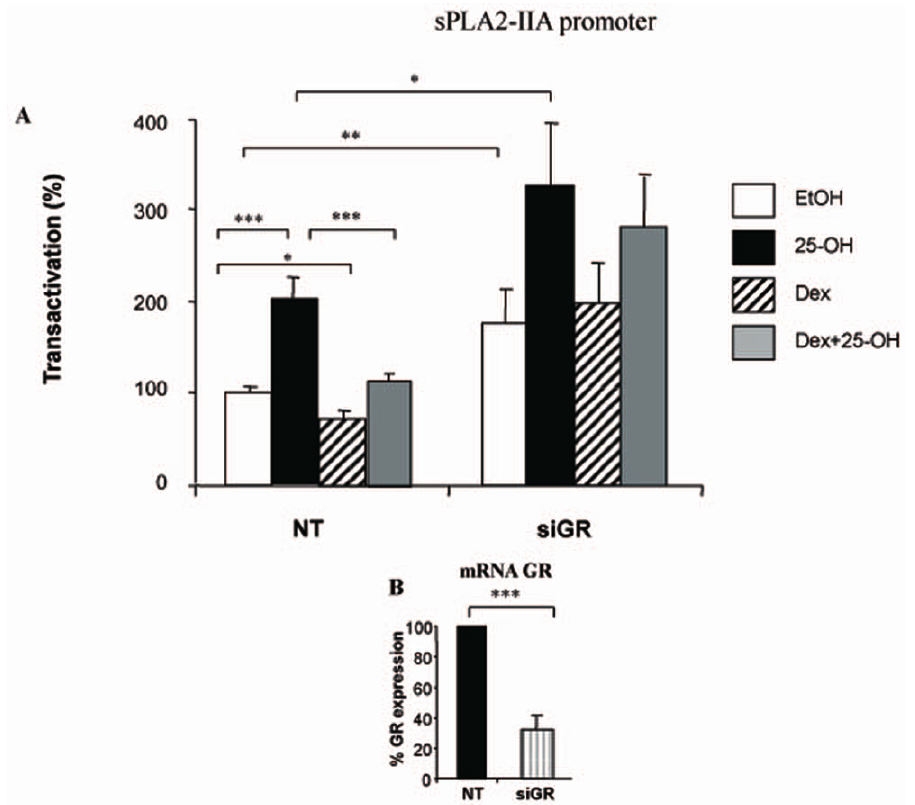
Figure 1. Effect of Dex and implication of the GR in sPLA2-IIA promoter activity. A/ 158N cells were transiently transfected with 0.2 m g of sPLA2-IIA(1 kb) and 0,1 m g of pRSV- b Gal plasmids in the presence of 0.2 m g of mock vector (NT) or siRNA directed against the GR (siGR). Eighteen hours after transfection, cells were incubated with 25-OH (10 2 5 M) and/or Dex (10 2 6 M) for 24 h, and then luciferase and b -galactosidase activities were analyzed. Results are expressed as percentage of the basal activity; they represent the mean + / 2 SEM of 10 independent experiments performed in duplicate. In all experiments *p , 0.05, **p , 0.01, ***p , 0.001 by using Bonferroni’s test after ANOVA. B/ Test of the efficacy of the siRNA: Total RNA from 158N cells transfected with either non targeting siRNA or siRNA against GR was prepared. Real time RT-PCR was performed. 26S RNA was detected by specific primers and used to normalize GR expression levels.